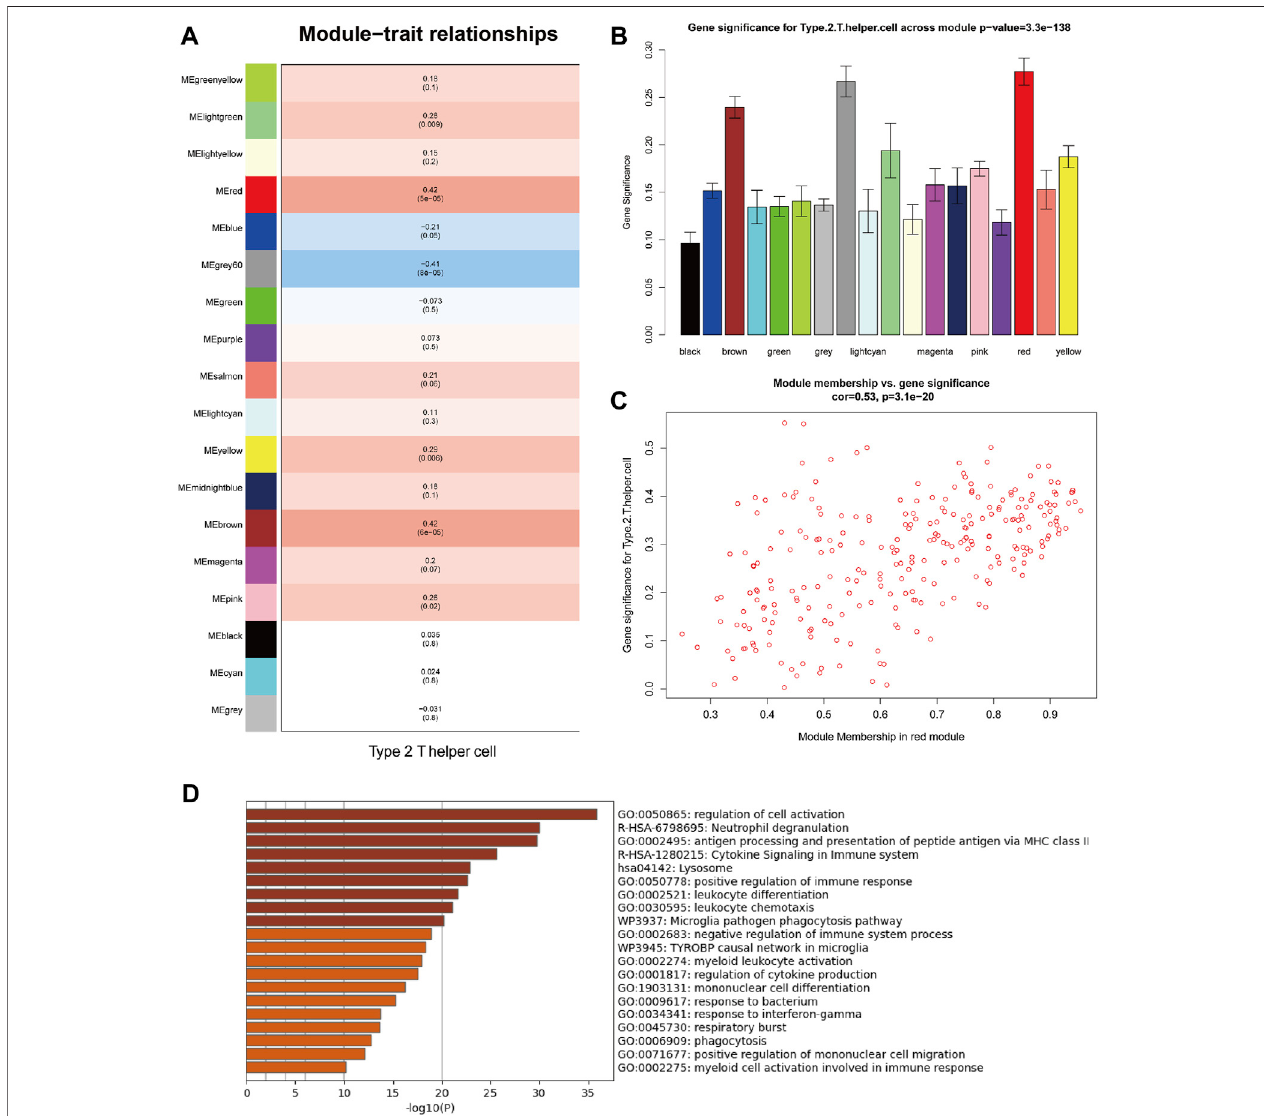
FIGURE 3 | Weighted gene co-expression network analysis (WGCNA) of MPM samples from TCGA. (A) Correlations between module eigengenes (MEs) and Th2 cell in fi ltration levels. (B) Gene signi fi cance (GS) for Th2 cell in fi ltration levels across all modules. (C) Gene signi fi cance (GS) of the genes contained in the red module versusmodulemembership(Th2 cellin fi ltrationlevels). (D) Functionalenrichmentanalysisofgenescontainedintheredmodule(Functionalenrichmenttermscoloredby p